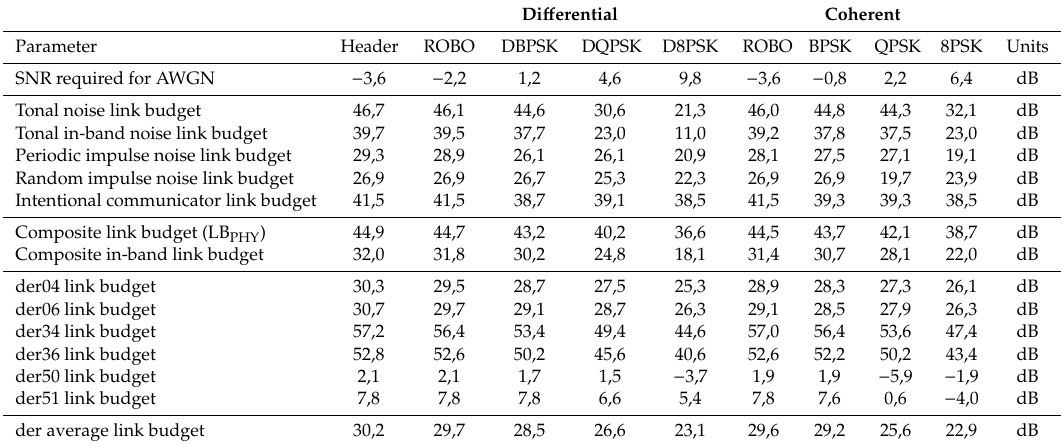
Table 9, i.e., G3-PLC performance results with a standard tone map implementation. Table 11. Absolute results with a tone map power reallocation in